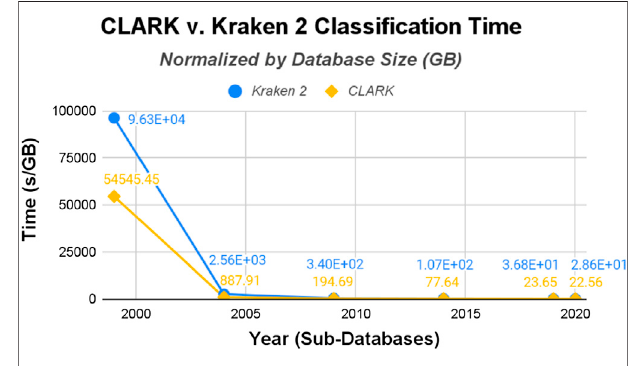
FIGURE 7 | CLARK and Kraken 2 Classi fi cation Time normalized by the size of the databases (seconds/Gigabyte).